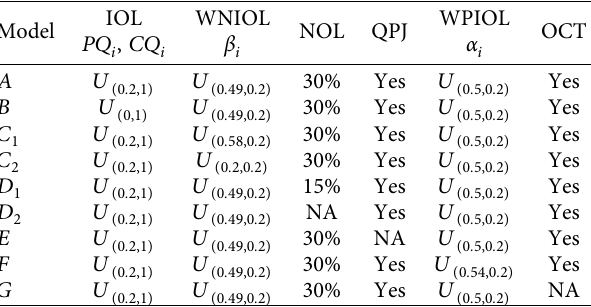
Table 3: Experimental parameter settings.